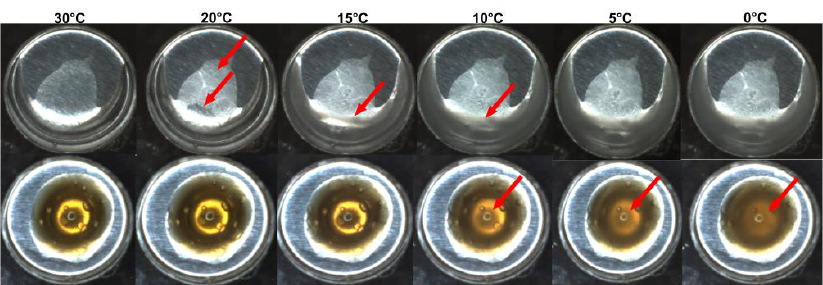
Figure 6. Respective images of hydrogel samples were recorded simultaneously by video during the DSC analysis. The range of temperature from the left to the right was: 30 °C, 20 °C, 15 °C, 10 °C, 5 °C, and 0 °C. The images are, respectively, taken from the following samples: hydrogel without VADE ( up-panel ) and VADE-loaded-hydrogel ( down-panel ). The arrows show the main physical changes observed in the samples.